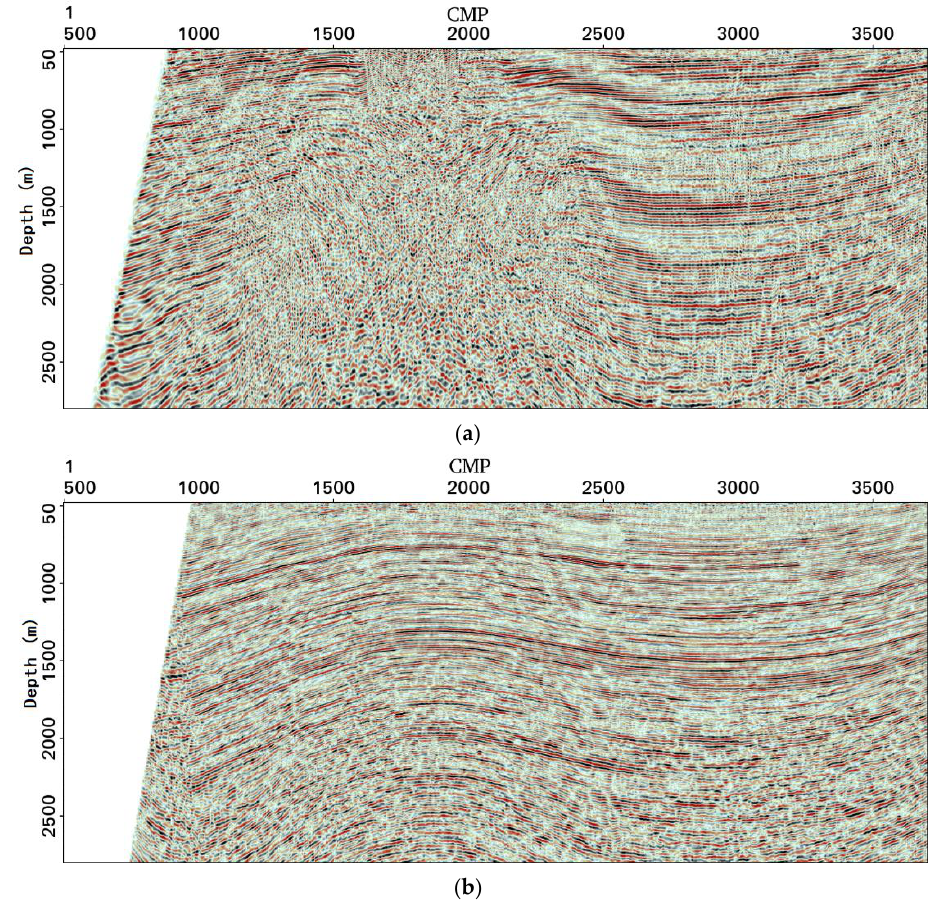
Figure 10. Pre-stack depth migration sections using RTM: ( a ) the P-wave, Δ x = 5 m, Δ z = 2 m; ( b ) the SH shear wave, Δ x = 5 m, Δ z = 2 m.